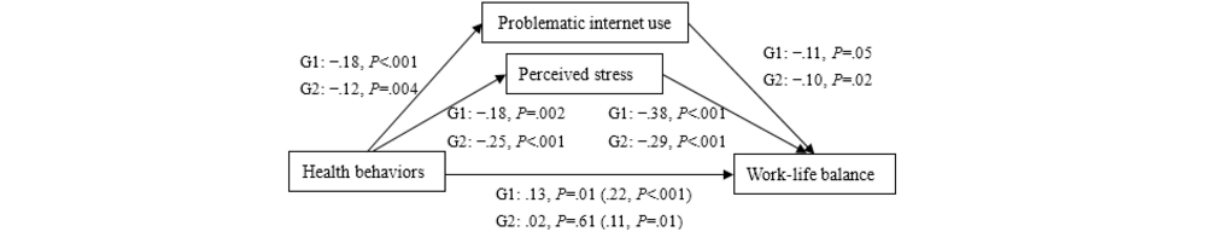
Figure 2. Multiple mediation model with standardized regression coefficients predicting work-life balance in both groups. G1, Group 1: residents in Germany; G2, Group 2: residents in China.